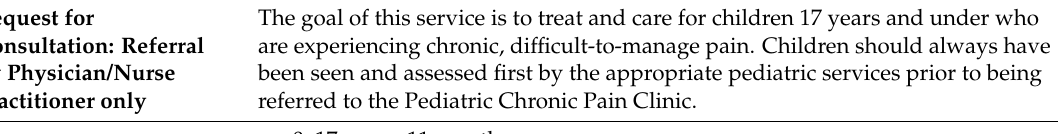
Table 1. Stollery Chronic Pain Clinic referral